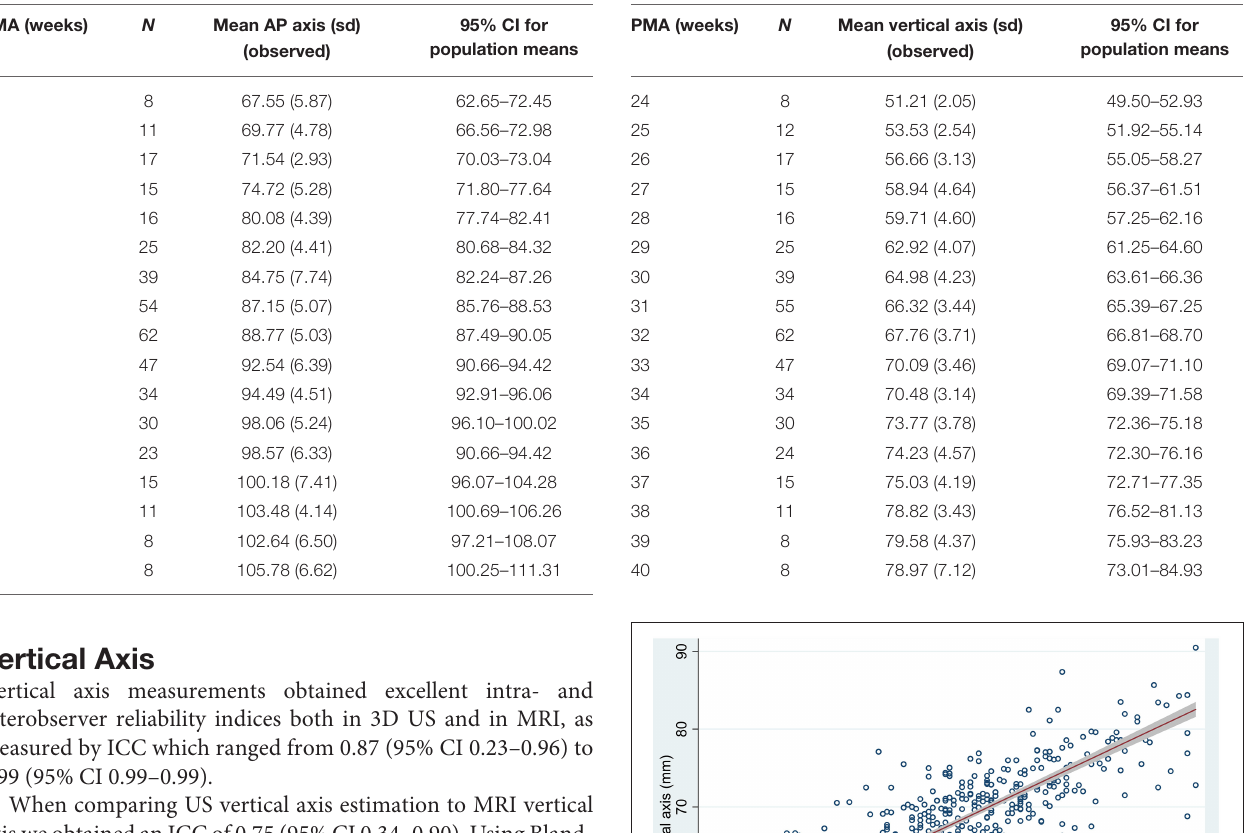
TABLE 5 | Mean US vertical axis (sd) in millimeters per week of post-menstrual age and 95% CI for population means.